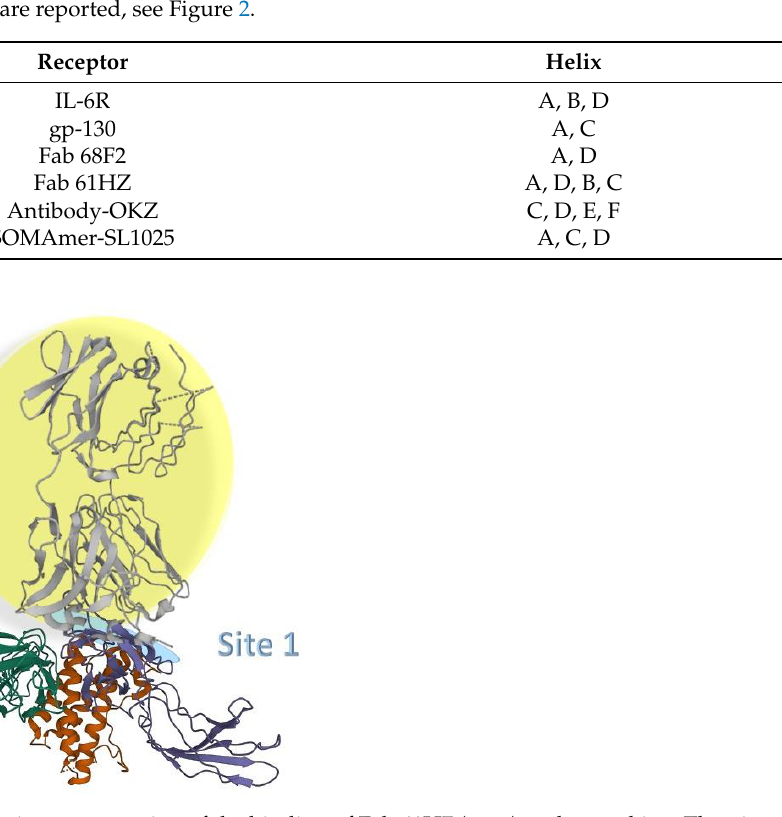
Figure 3. Schematic representation of the binding of Fab 61H7 (gray) to the cytokine. The picture is an artifact of the natural trimer and Fab 61H7 on site 1 and has the aim to make clearer the positions of different binding sites. Circles render site1 (cyan) and the antibody (yellow).